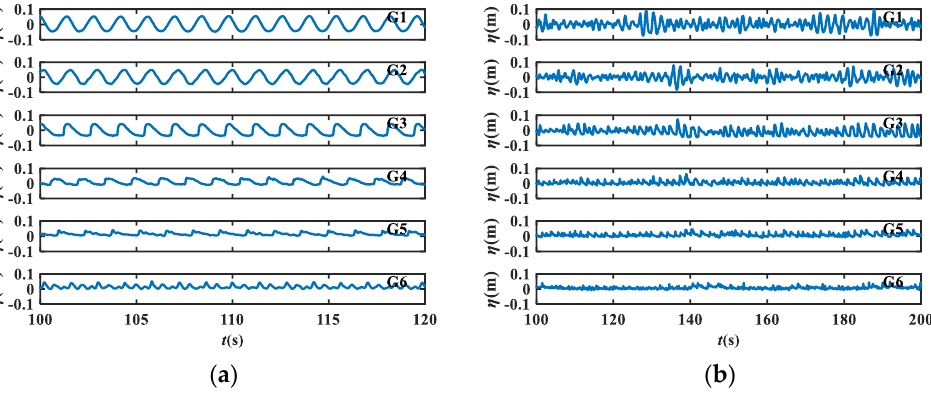
Figure 3. Time histories of free surface elevations for the reef at H 0 = 0.1 m ( H s 0 = 0.1 m), T 0 = 1.4 s ( T 0 = 1.4 s), cot θ = 3, h r = 0.05 m: ( a ) regular wave; ( b ) irregular wave.